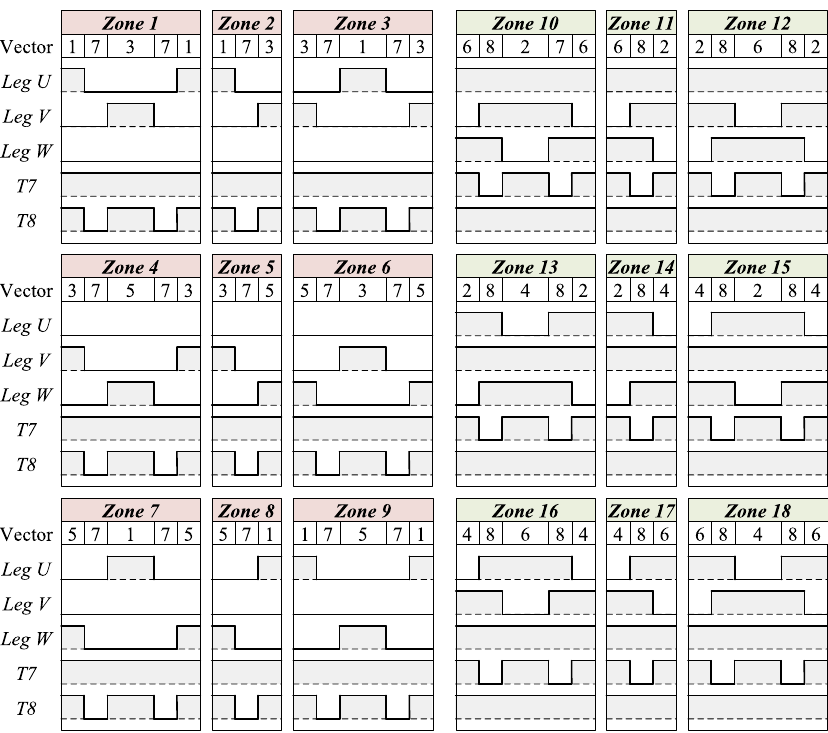
Figure 8. State sequences for CCMV SVM in H8 converter. Zones from 1 to 9 employ odd vectors,